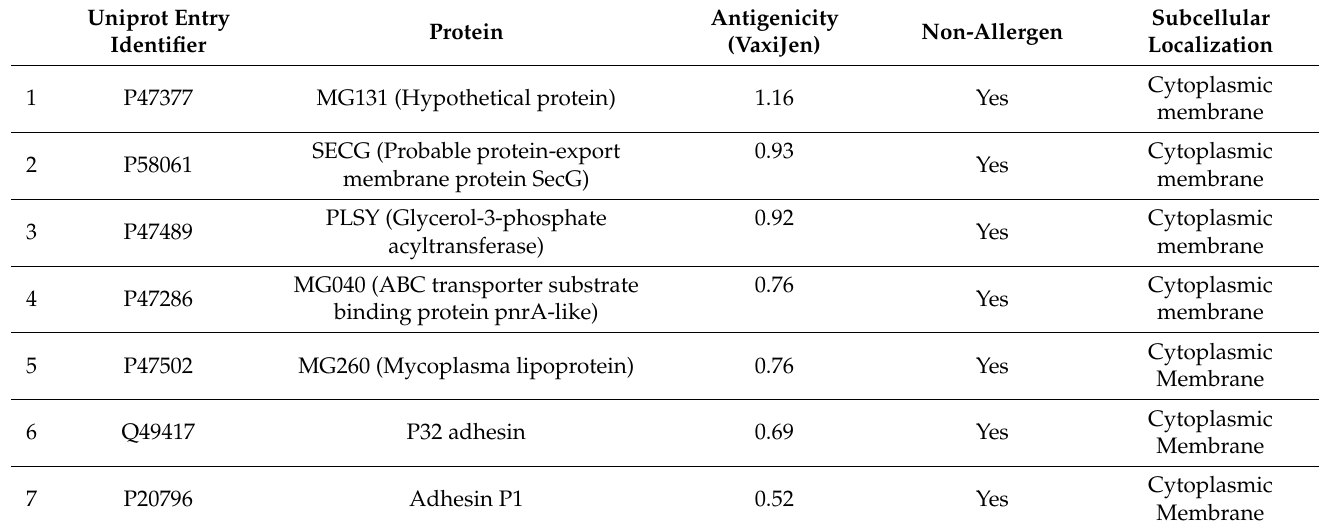
Table 1. Most immunogenic proteins selected as potential vaccine candidates in M. genitalium